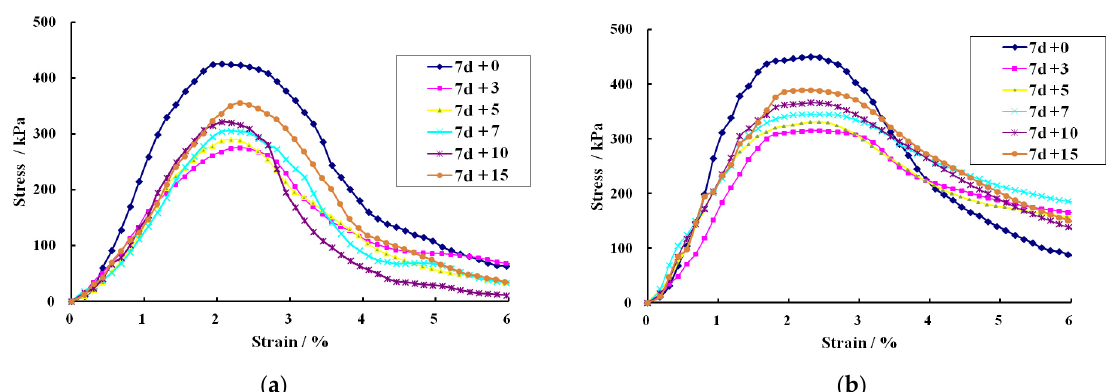
Figure 4. Stress–strain curves of OCC and PCC under freeze–thaw cycles. ( a ) Ordinary coastal cement clay (OCC); ( b ) polypropylene fiber coastal cement clay (PCC).